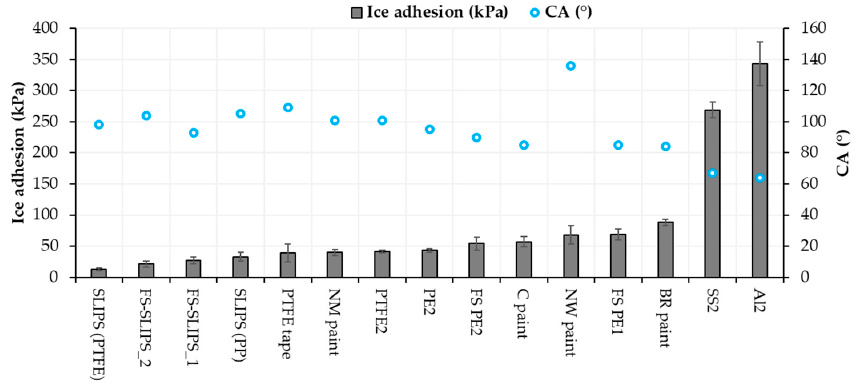
Figure 9. Ice adhesion and static contact angle relationships of the selected materials and surfaces.